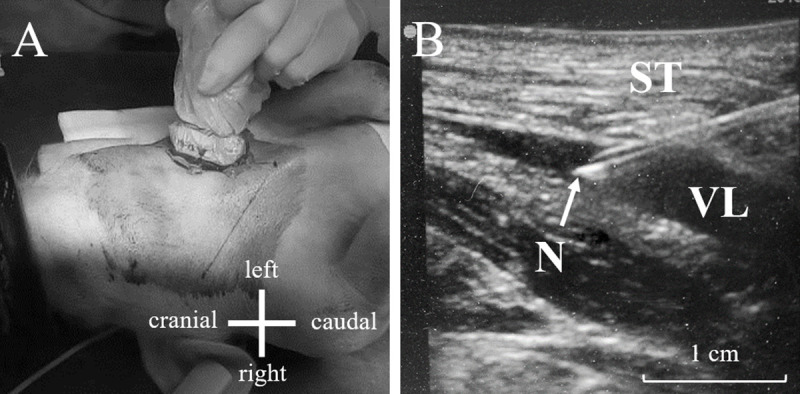
A. Photograph that shows the positioning of the ultrasound transducer on the marked line (expected passage of external jugular vein); B. Visualization of the 21G echogenic needle entering the venous lumen; ST = subcutaneous tissues (muscle); VL = venous lumen; N = echogenic needle.